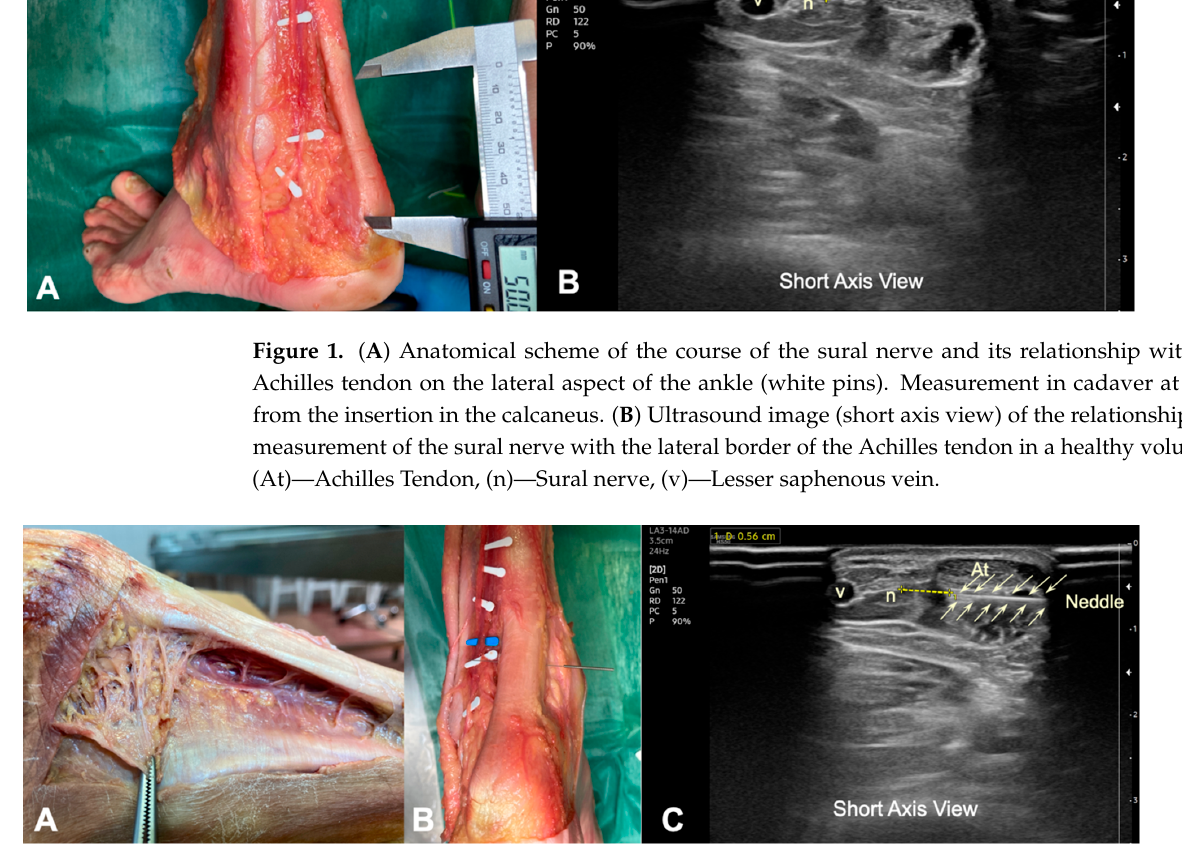
Figure 2. ( A ) Cadaveric view of the relationship between Kager’s fat and the deep face of the Achil- les tendon. ( B ) Cadaveric detailed view of the needling insertion at the interphase between the Achilles tendon and Kager’s fat at 5 cm from the insertion in the calcaneus. ( C ) Ultrasound image (short axis view) of the measurement from the tip of the needle to the sural nerve inserted at the Kager’s fat–Achilles tendon interphase (from medial border) measured 5 cm from the insertion in the calcaneus. (At)—Achilles Tendon, (n)—Sural nerve, (v)—lesser saphenous vein. (At)—Achilles Tendon, (n)—Sural nerve, (v)—lesser saphenous